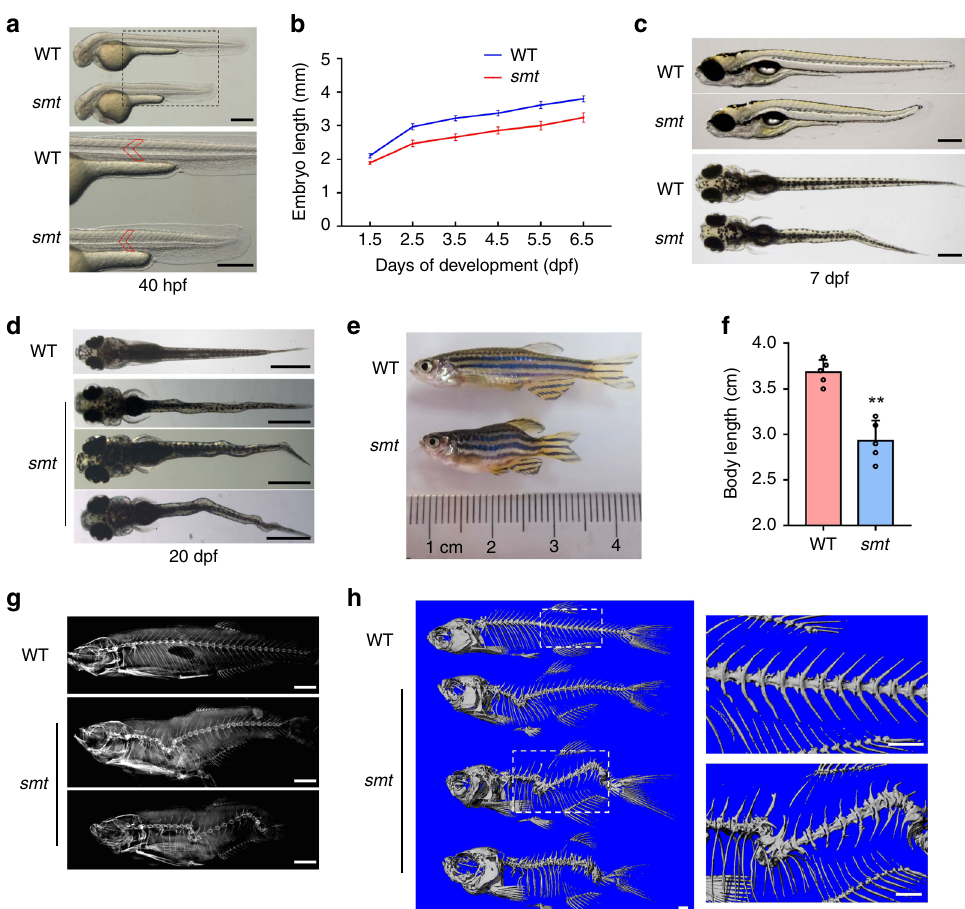
Fig. 1 Smt mutation leads to CS-like vertebral malformations. a Bright- fi eld images showing shortened somites and body length in smt mutant at 40 hpf. The bottom panel showed enlarged parts. Red line marks single somites. b Graph depicting the body length measurements of WT (blue line) and smt mutant (red line) from 1.5 dpf to 6.5 dpf, n = 20 independent embryos for WT and smt mutant. Data points represent average body length and error bars represent standard deviation. c Lateral (top) and dorsal views (bottom) showed slight wavy bending in smt mutant at 7 dpf. d At about 20 dpf, smt mutant showed different degrees of curve severity in dorsal view: mild (top), moderate (middle) and severe (bottom) curvature. e Whole mount image of 3- month-old smt mutant (bottom) and WT (top). Smt mutants had scoliosis and quanti fi cation of the body length were much shorter than WT ( f ), n = 5 independent zebra fi shes for WT and smt mutant. ** p < 0.01. p values were determined by unpaired two-tailed Student ’ s t -test. X-rays ( g ) and three- dimensional micro-CT ( h ) revealed severe scoliosis and kyphosis in smt mutant (bottom). Boxed regions are magni fi ed in the right panel in ( h ). Data are presented as mean ± SD. Scale bar represent 200 μ m in ( a) , 400 μ m in ( c ), 1 mm in ( d and h ), 2 mm in ( d ). Source data are provided as a Source Data fi